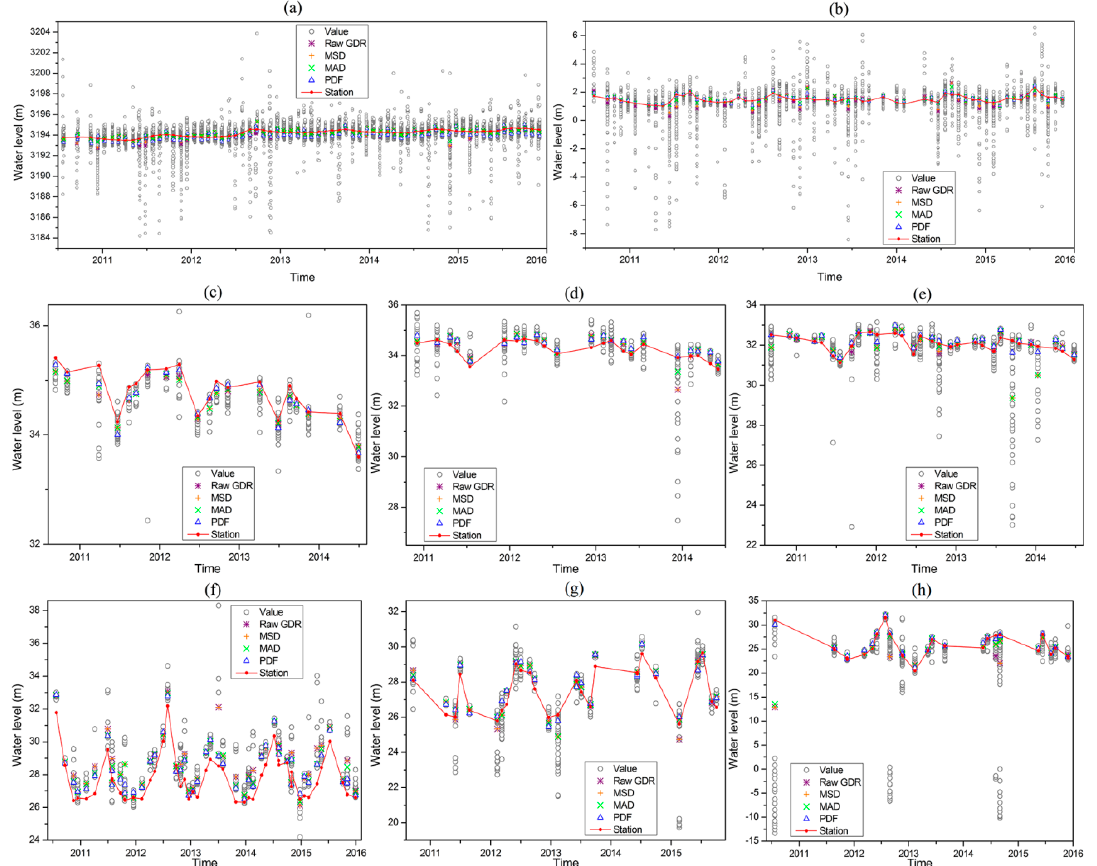
Figure 5. Altimetry and in situ gauge lake levels for ( a ) Qinghai Lake, ( b ) Tai Lake, ( c ) Nanyang Lake, ( d ) Dushan Lake, ( e ) Weishan Lake, ( f ) West Dongting Lake, ( g ) South Dongting Lake, and ( h ) East Dongting Lake. The symbols are the same as Figure 4.